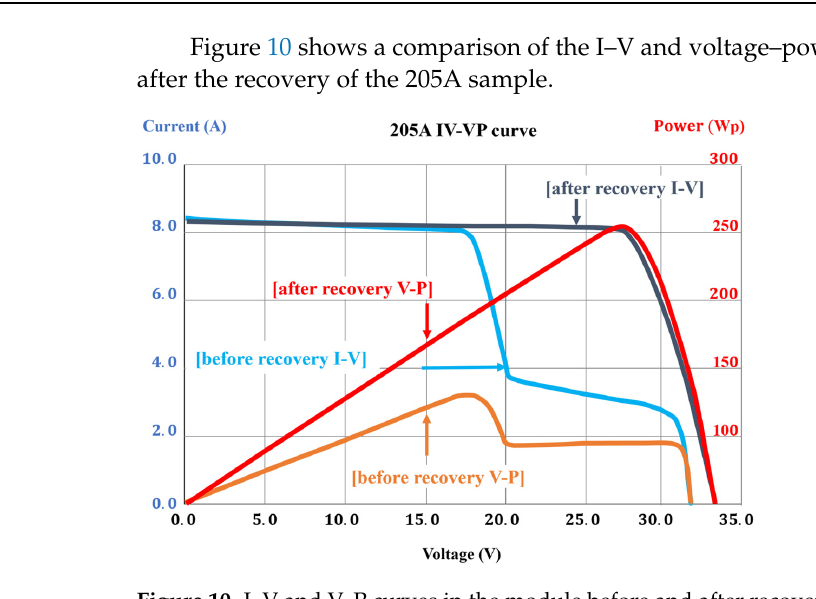
Table 5. Electrical data before and after replacement of short-circuit diode (205A).